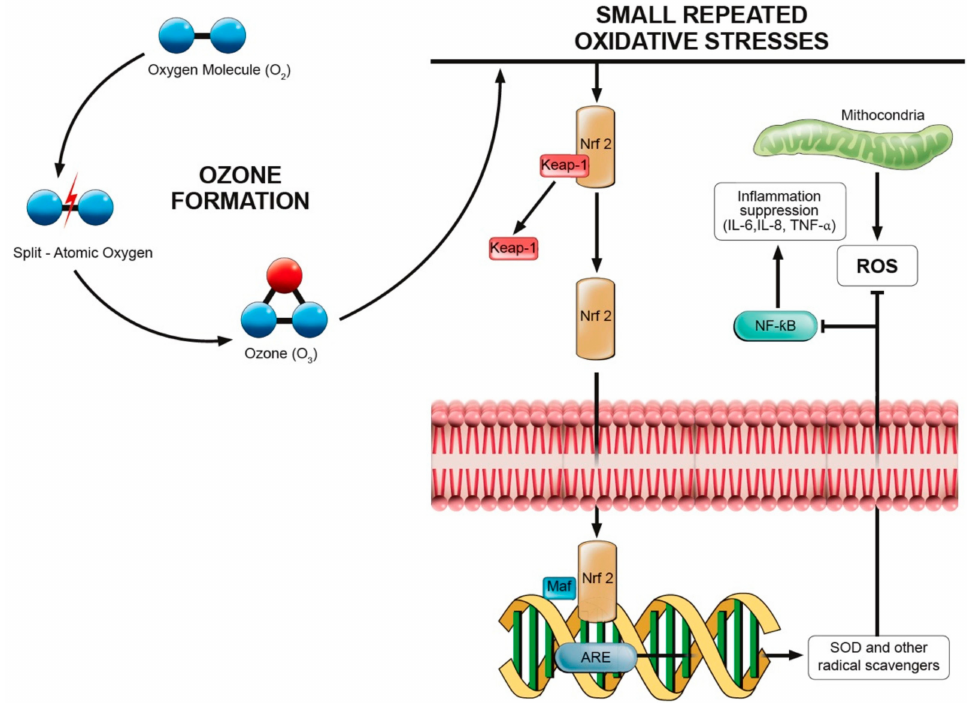
Figure 1. Ozone (O 3 ) formation mechanism and intracellular and intranuclear pathways involved in inflammation and oxidative